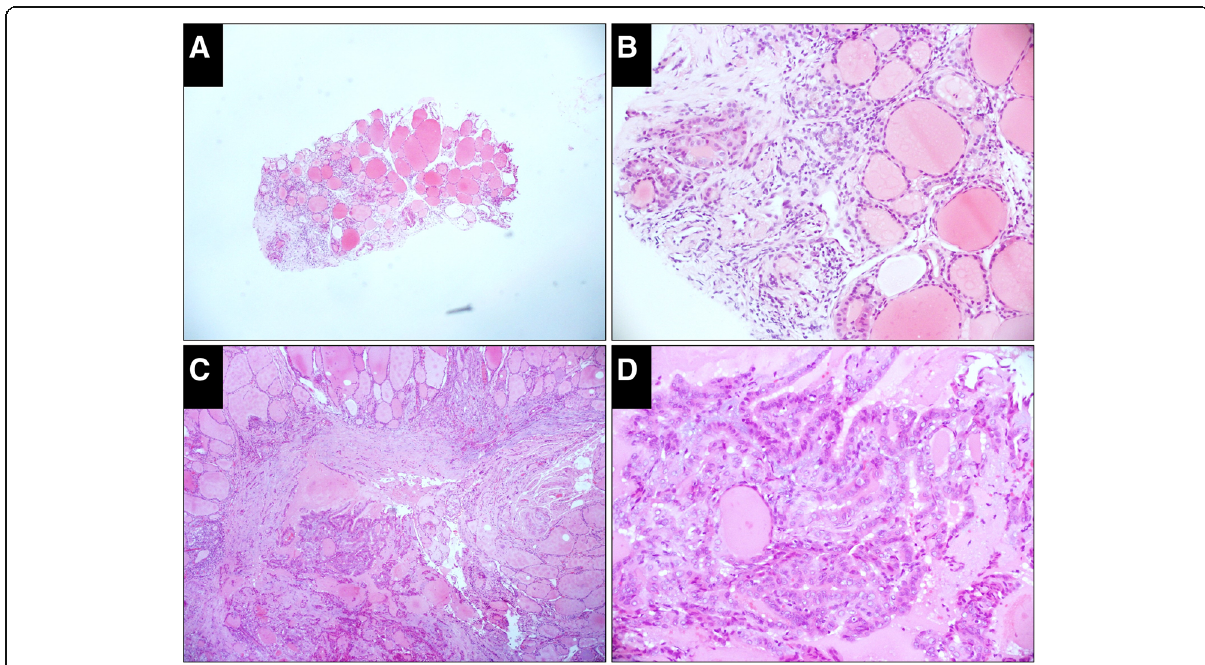
Fig. 5 Case classified as suspicious for malignancy in the CNB specimen but malignant in the resected specimen (H&E). a , The CNB specimen is mainly composed of normal thyroid follicles except for a focal fibrotic lesion at the end (× 50). b , High-power view of the fibrotic lesion shows several embedded small tubules and the cell nuclei possess the features of papillary thyroid carcinoma (× 200). c , A circumscribed sclerosing nodule is prominent in the resected specimen, with a number of small tubules and elongated glands (× 50). d , High power view of the cells shows nuclei with the features of papillary thyroid carcinoma (×